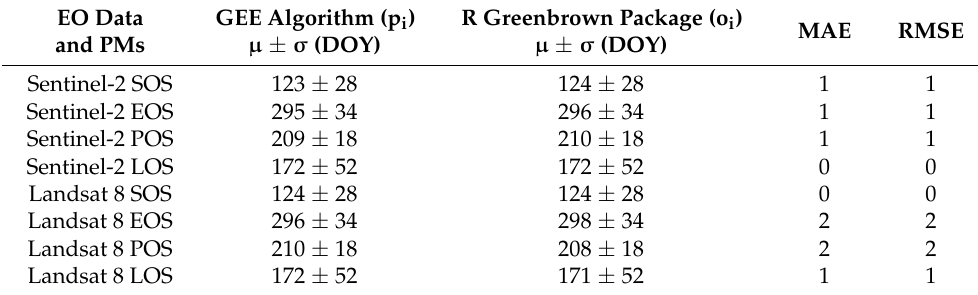
Table 2. Phenological Metrics comparison.